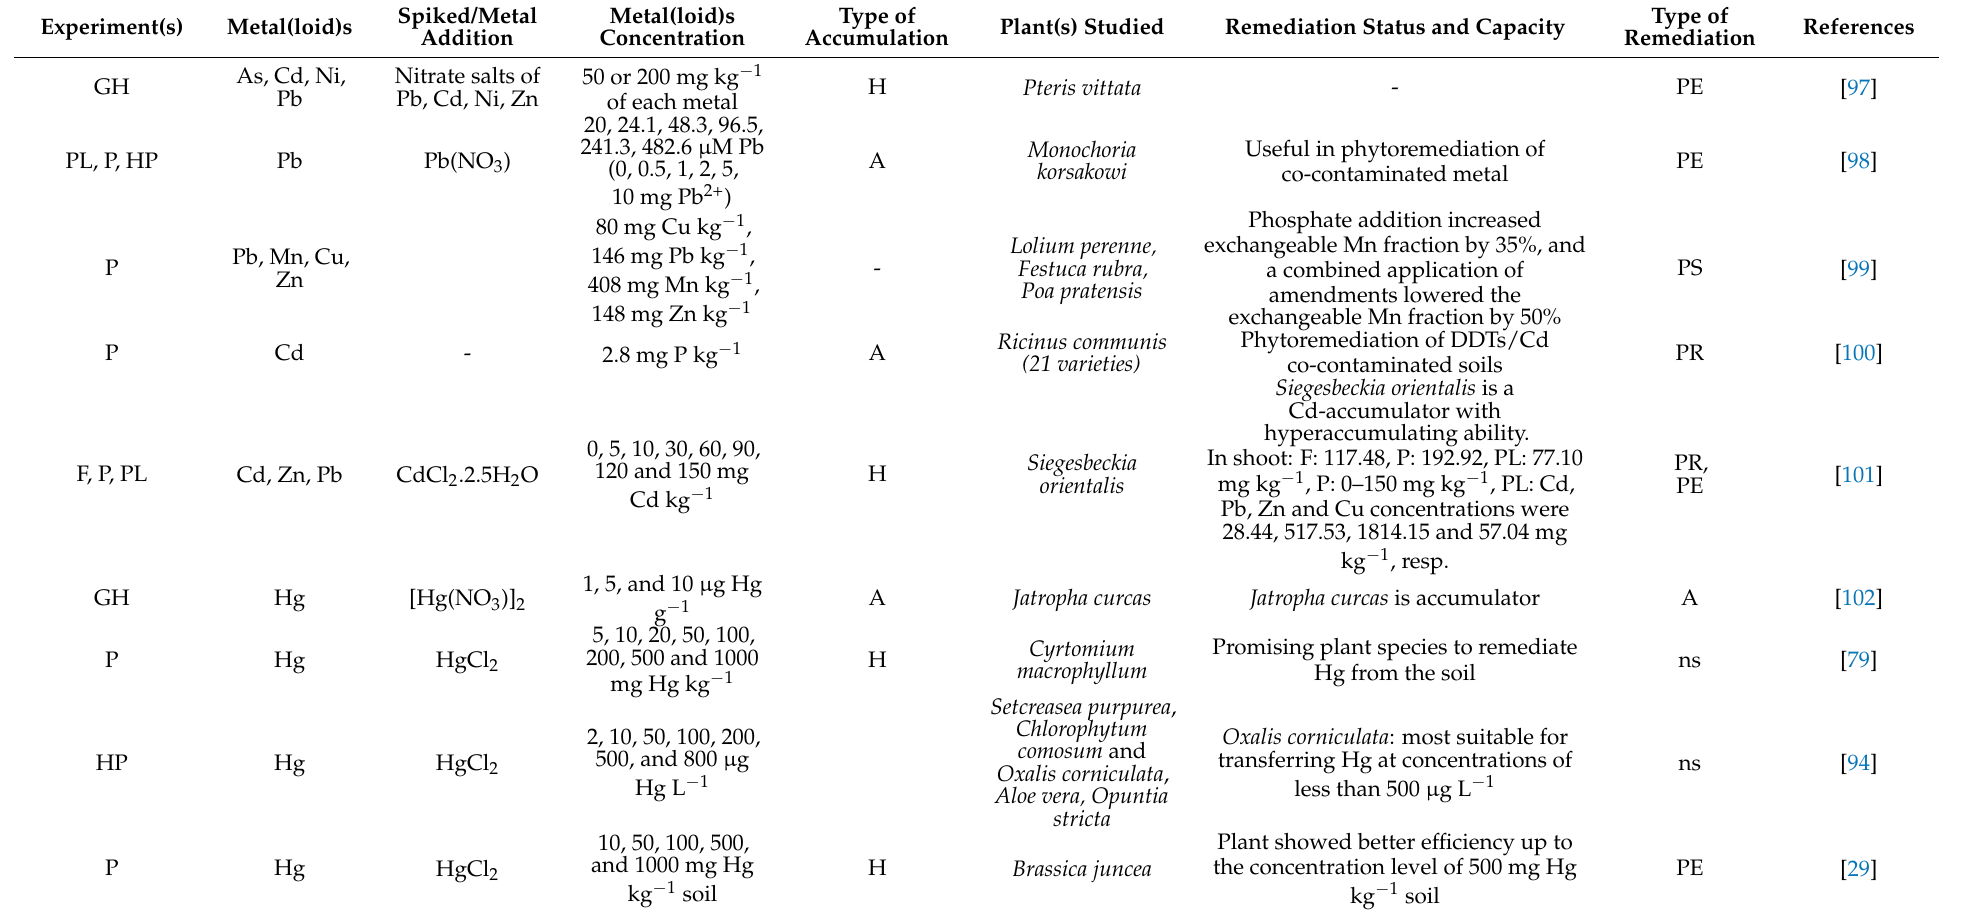
Table 3. List of competent plant species used to study the remediation potential in both naturally and artificial metal-contaminated site/substrate.